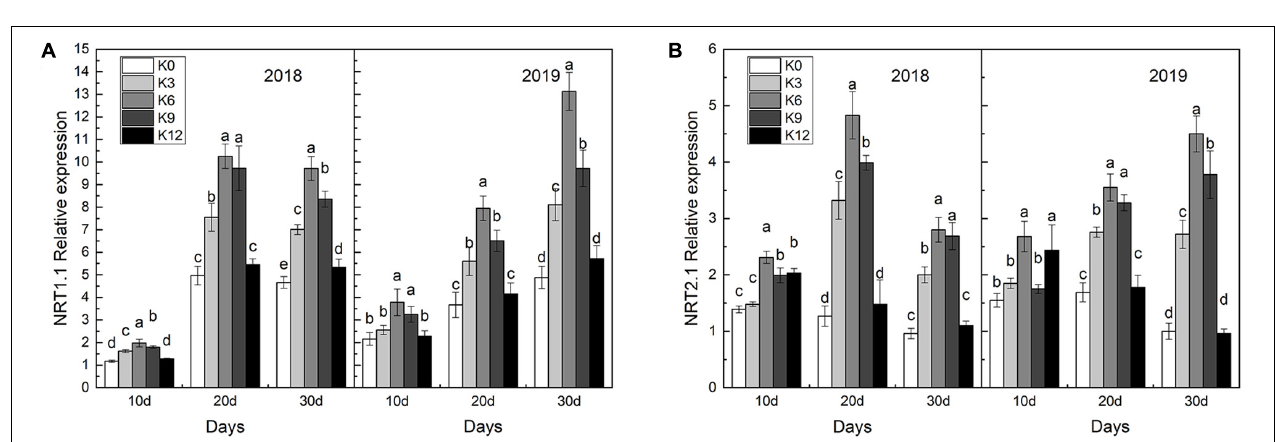
FIGURE 6 | NR activities in the leaves (A) and roots (B) ; GS activities in the leaves (C) , and roots (D) of M9T337 seedlings treated with K0 (0 mM K + ), K3 (3 mM K + ), K6 (6 mM K + ), K9 (9 mM K + ), or K12 (12 mM K + ) in 2018 and 2019. Each treatment had three biological replicates and the assays were repeated three times. Vertical bars indicate ± SD ( N = 3). Different letters indicate statistically significant differences ( P < 0.05).